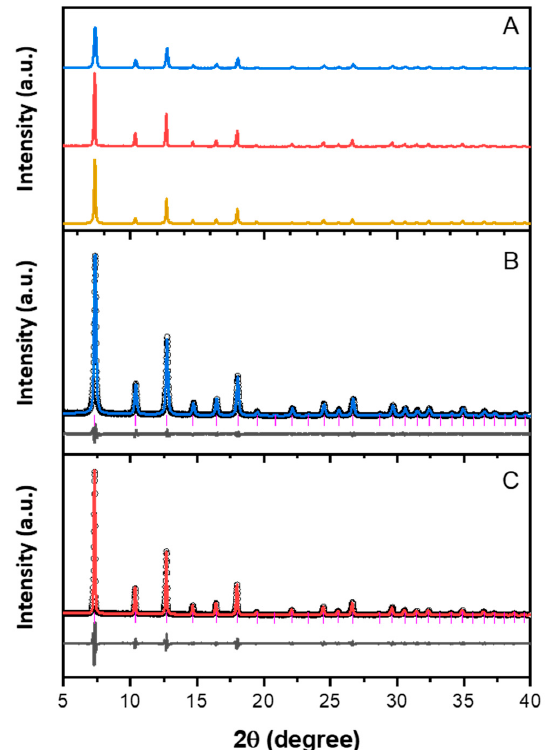
Table 1. Crystallographic parameters obtained by powder XRD analysis.